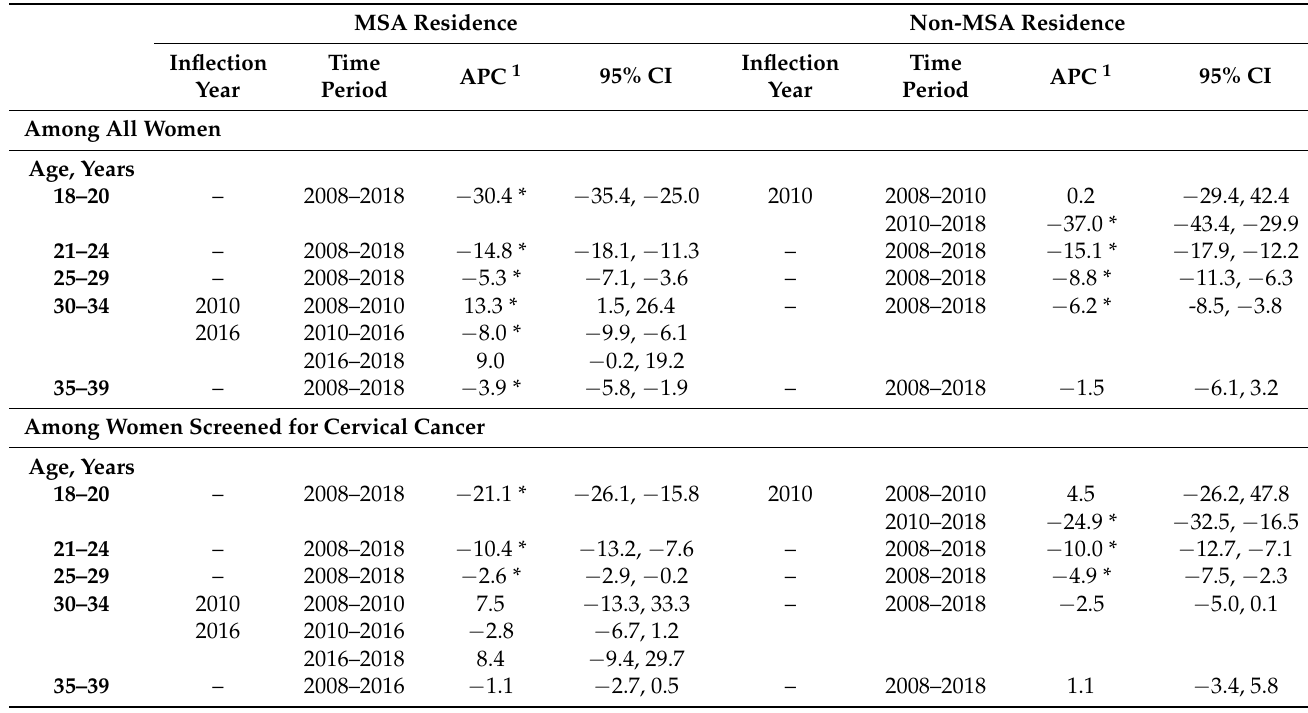
Table 3. Annual percent changes in age-group-specific CIN2+ incidence among all women enrolled in Tennessee Medicaid and the subset of women screened for cervical cancer, by urbanicity,